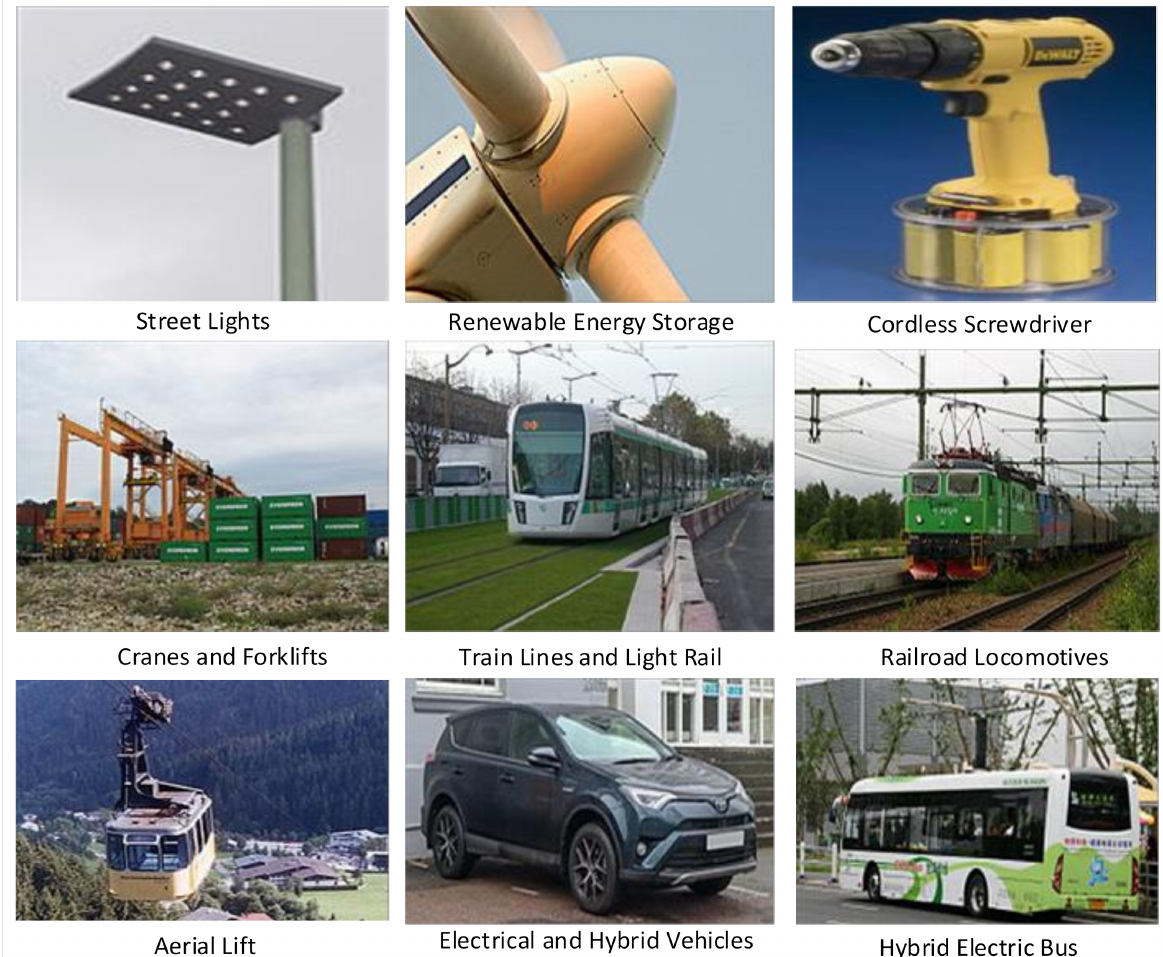
Figure 8. Some examples of SC